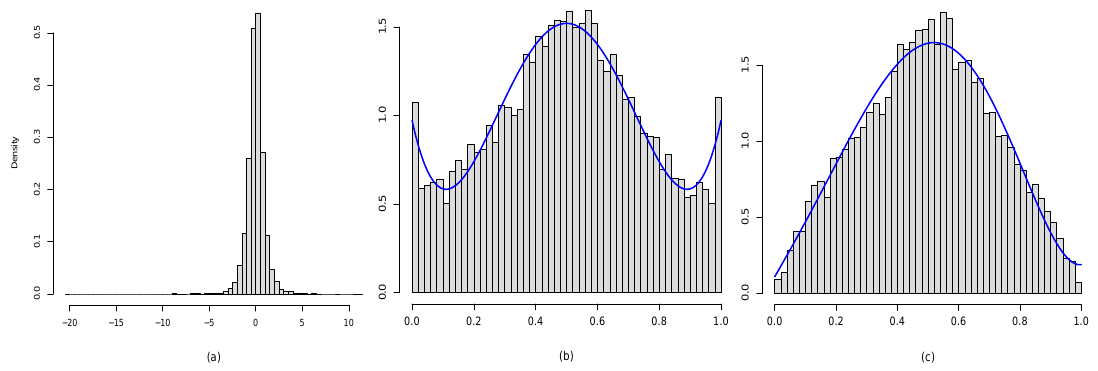
Figure 2. ( a ) The marginal distribution of daily returns; ( b ) plots the histogram of Φ ( y i ) and display the LP-estimated comparison density curve. and ( c ) shows the associated comparison density estimate with G as t -distribution with 2 degrees of